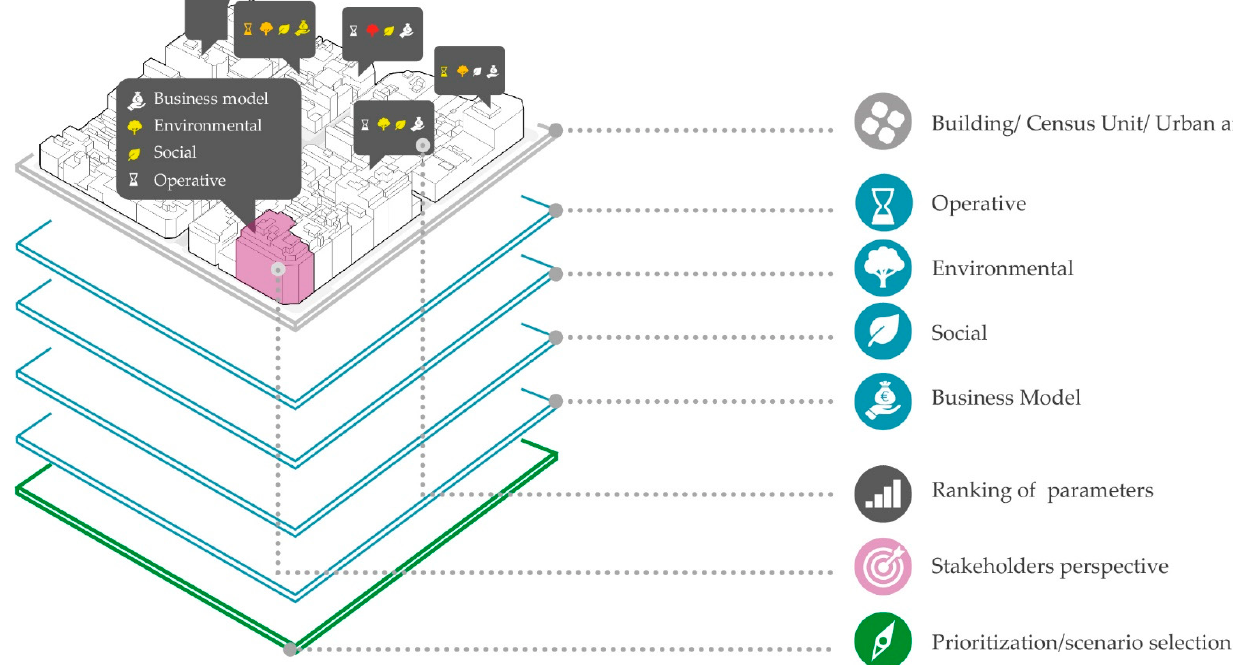
Figure 2. Multidimensional model indicators (layers) displayed in the platform and supporting residential building retrofitting programs. Source: authors.